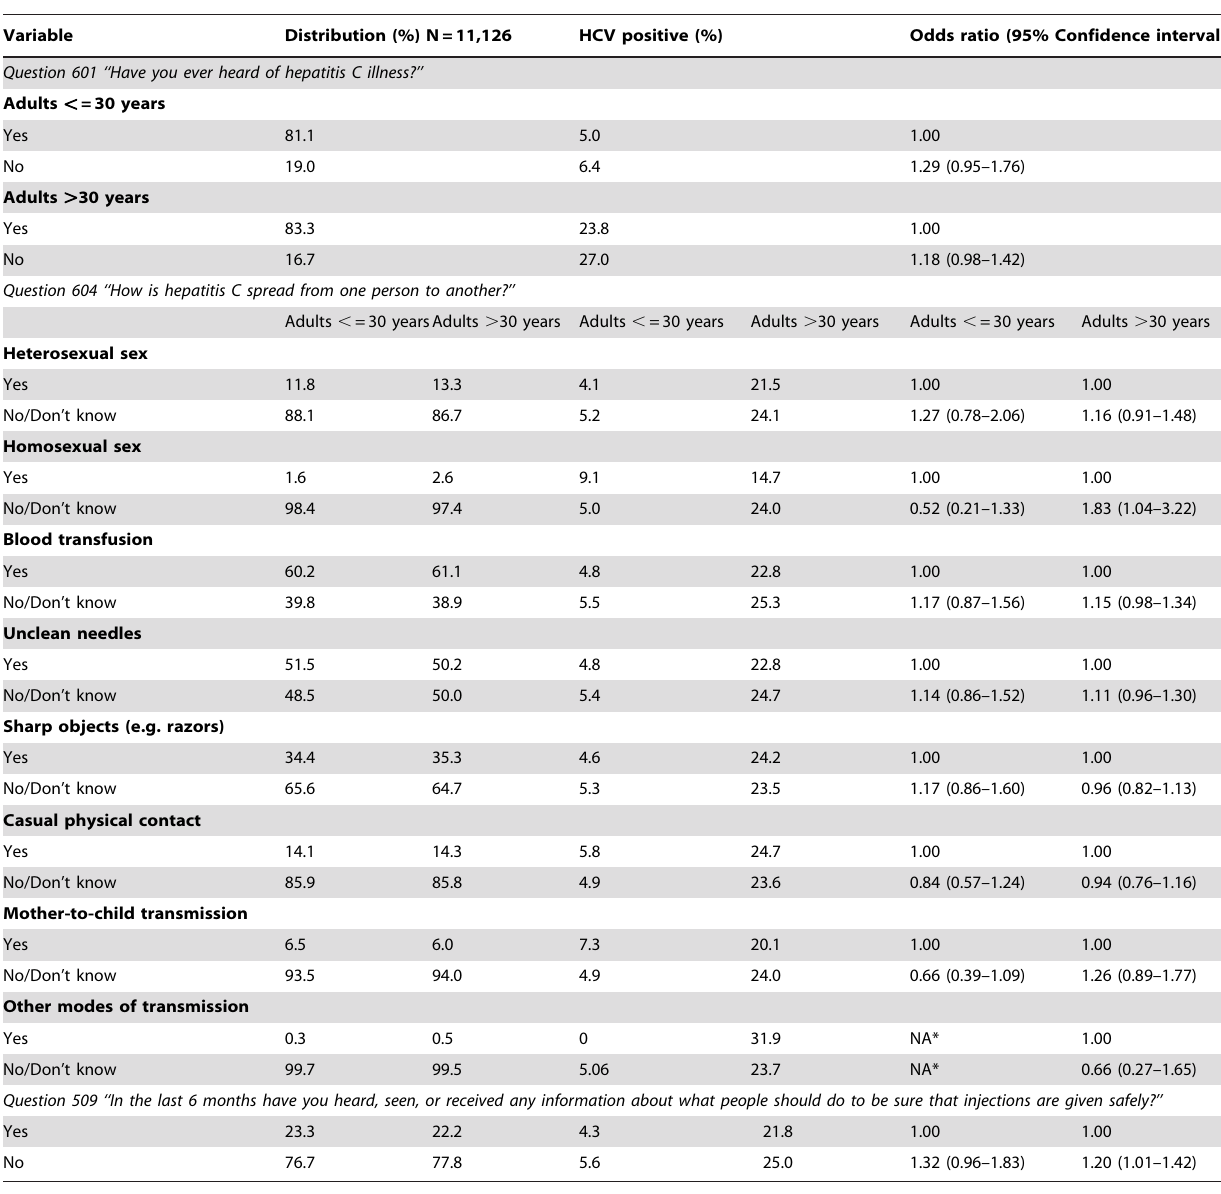
Table 2. Age-stratified analysis for the association between HCV knowledge-related questions and HCV antibody positivity among the Egyptian